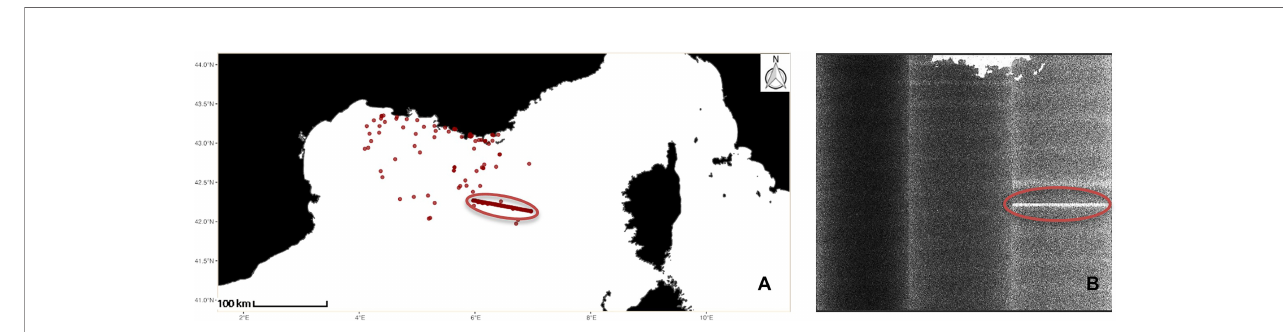
FIGURE 2 | Example of Radio Frequency Interference (RFI) in detections on a SAR image. (A) Detection plot of an image with RFI. (B) The SAR image used for the detection process (12/11/2020). Circled in red is the RFI that translates into a row of false positives in the detection plot. Copernicus Sentinel data